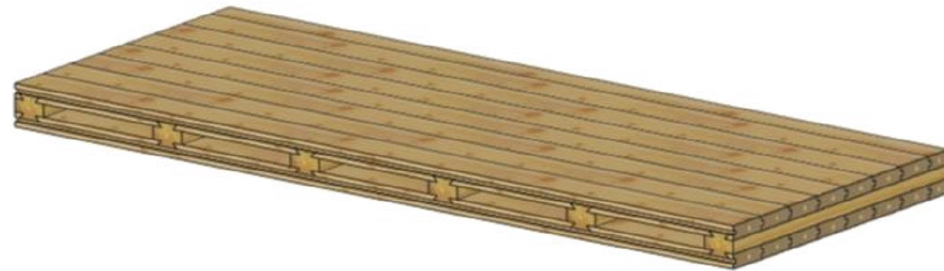
Figure 19. Dovetailed wooden panel for use as a structural element in buildings [135].